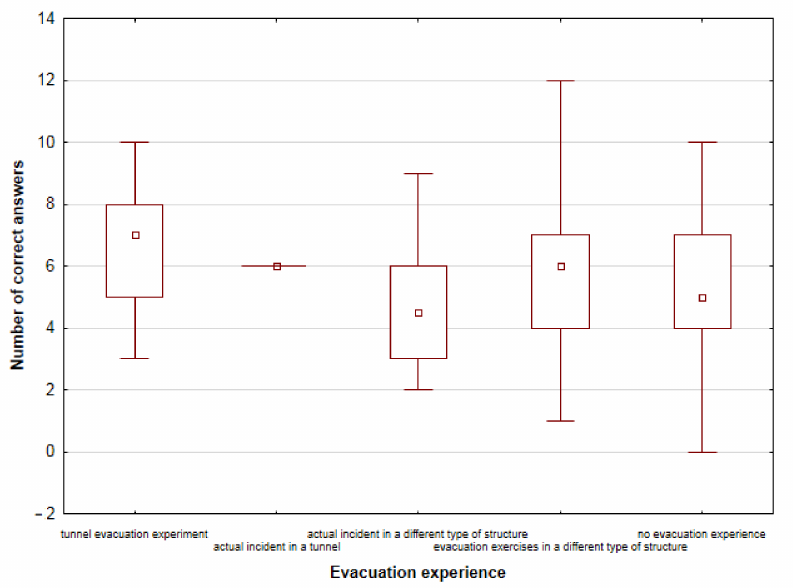
Figure 8. Knowledge of road tunnel safety procedures among the respondents who had experience related to evacuation in various